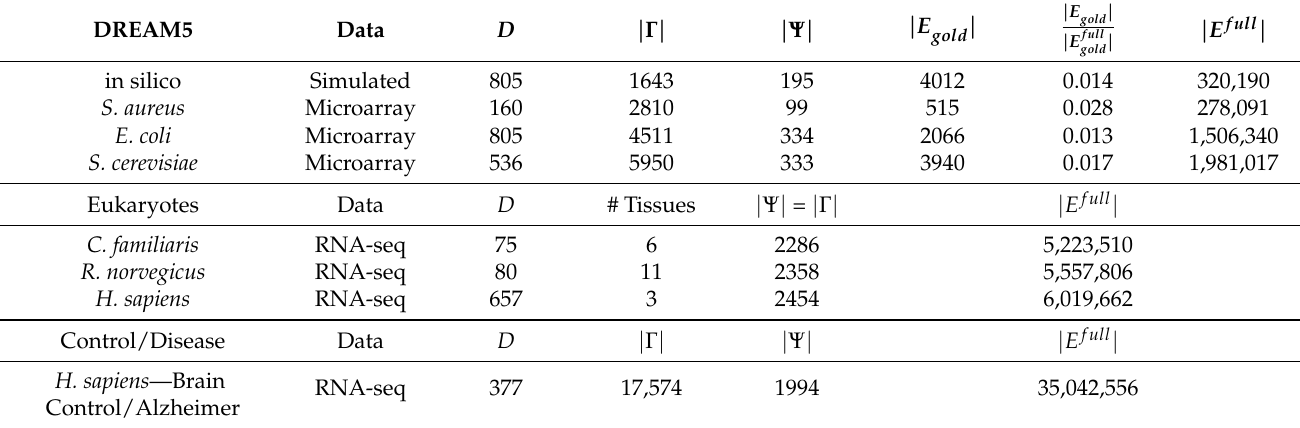
Table 1. DREAM5 Benchmark and RNA-seq eukaryotic dataset